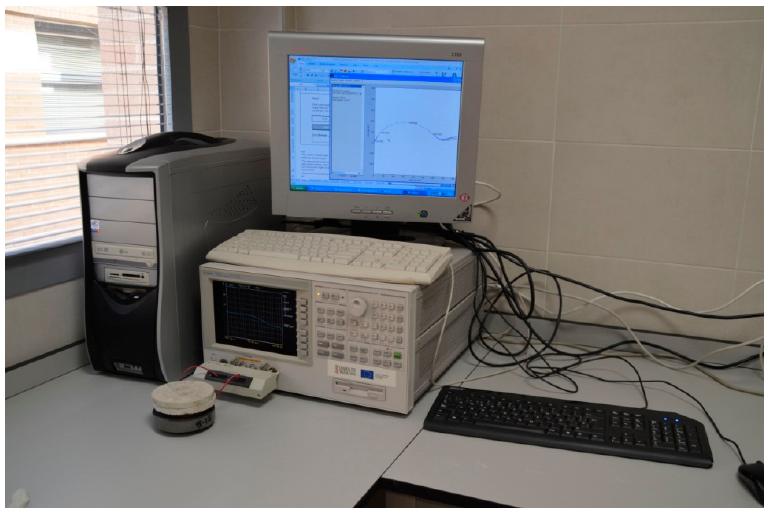
Figure 1. Experimental setup of the impedance measurement of a mortar sample using the contacting method.